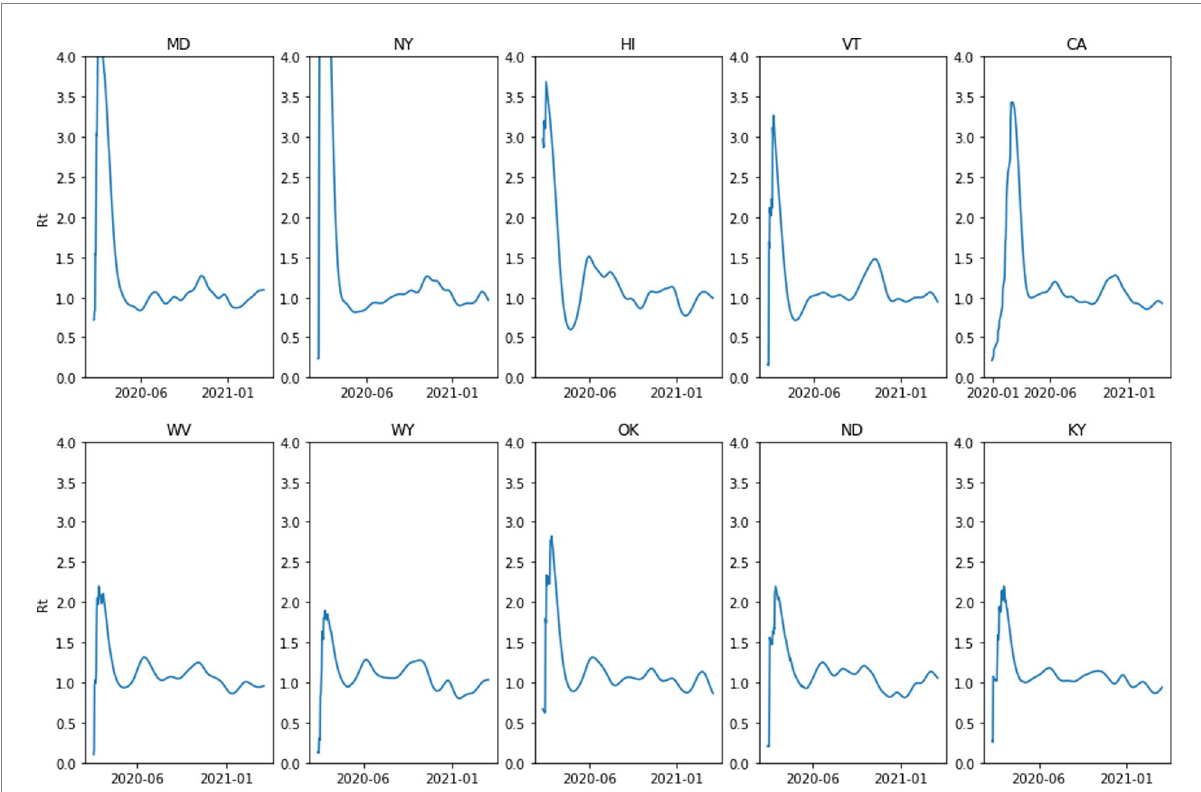
FIGURE 7 The effective reproduction number for the first three waves of COVID-19 in the United States for the top five states that voted for the 2016 Republican presidential candidate (bottom) and top five that voted for other candidates